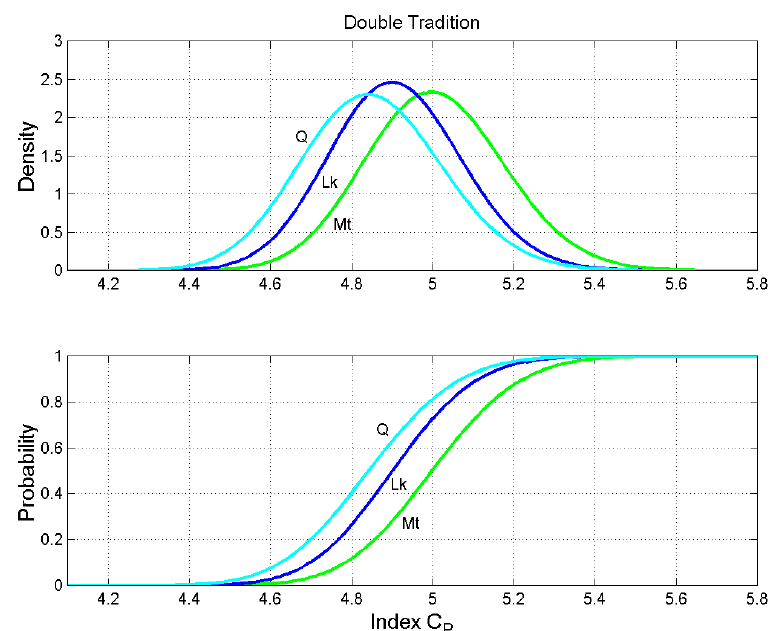
Figure 10. Double Tradition. Probability density functions (upper panel) and probability distribution functions (lower panel) of the number of characters per word 𝐶 𝑃 . Matthew : green line; Luke : blue line; Q : cyan line.